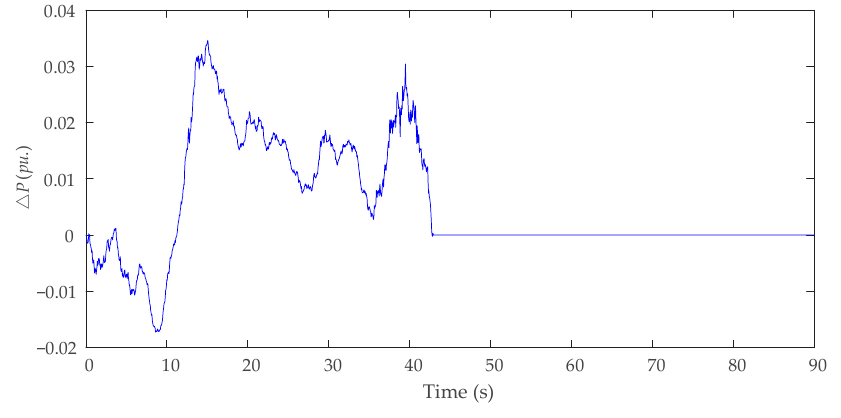
Figure 12. Wind power disturbance.